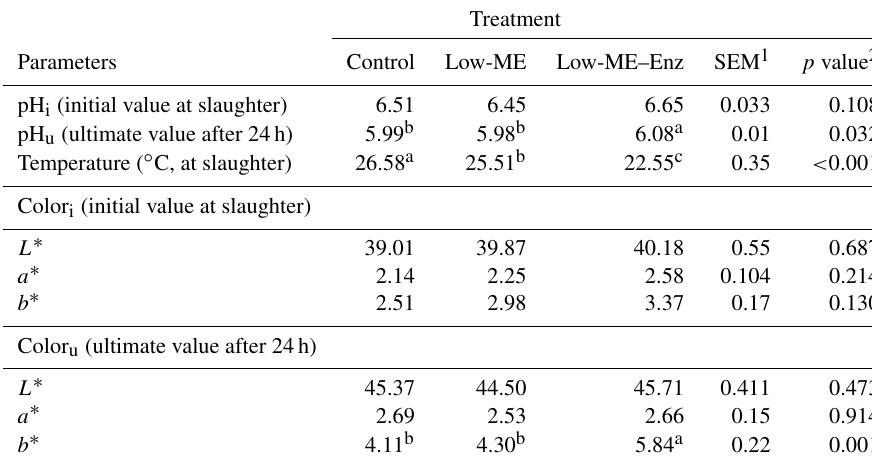
Table 5. Effects of dietary treatments on the color and pH of broiler chicken meat.